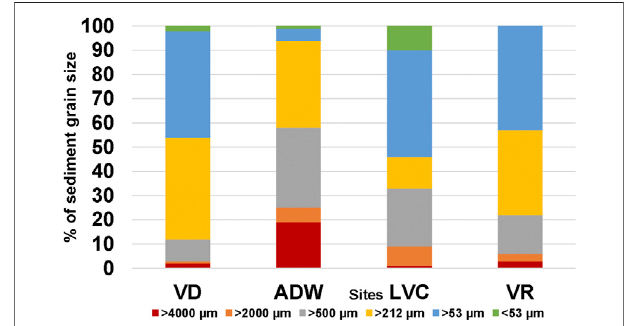
FIGURE 5 | Bar graph indicating the percentage composition of the sediment grain pro fi le at each site. Showing the larger sediment particles sampled at